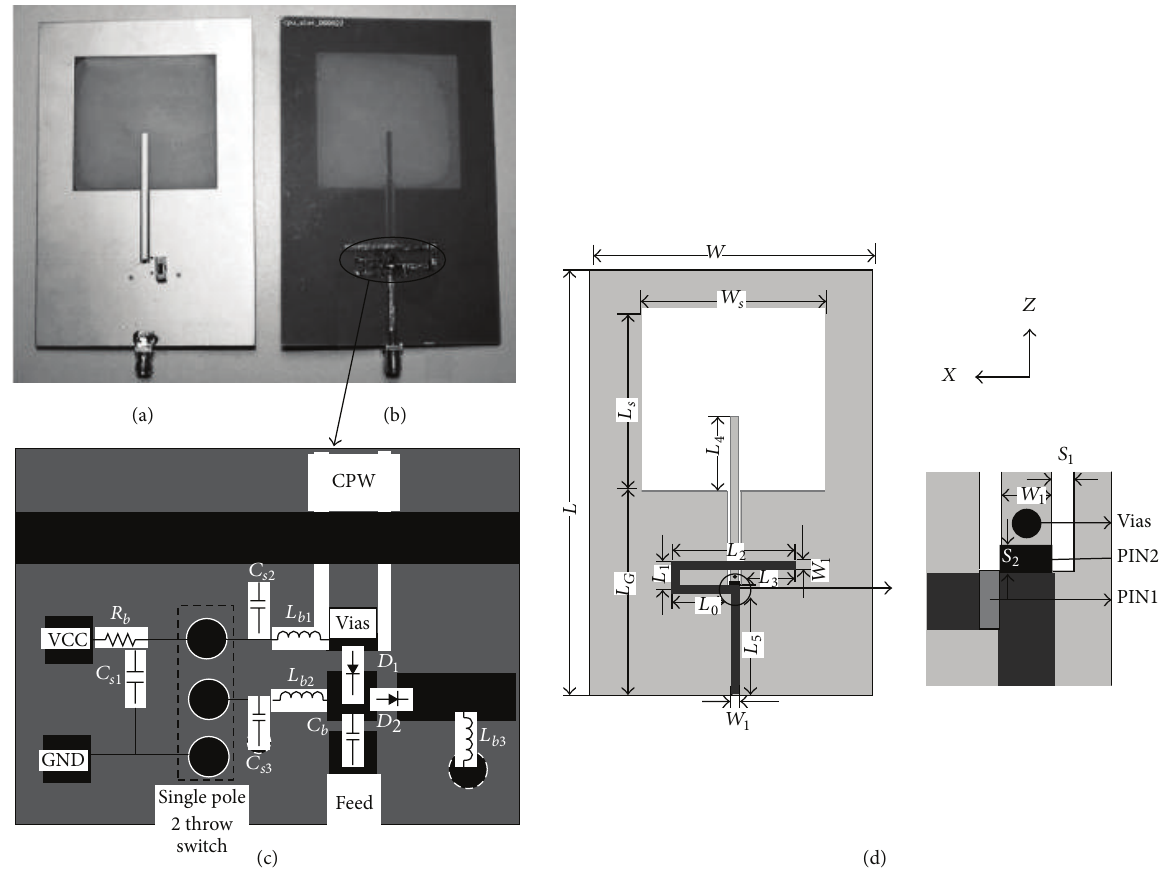
Figure 8: (a) Front side of fabricated polarization reconfigurable antenna. (b) Back side. (c) Bias circuit of the feed. (d) Geometric structure (with permission from John Wiley and Sons).